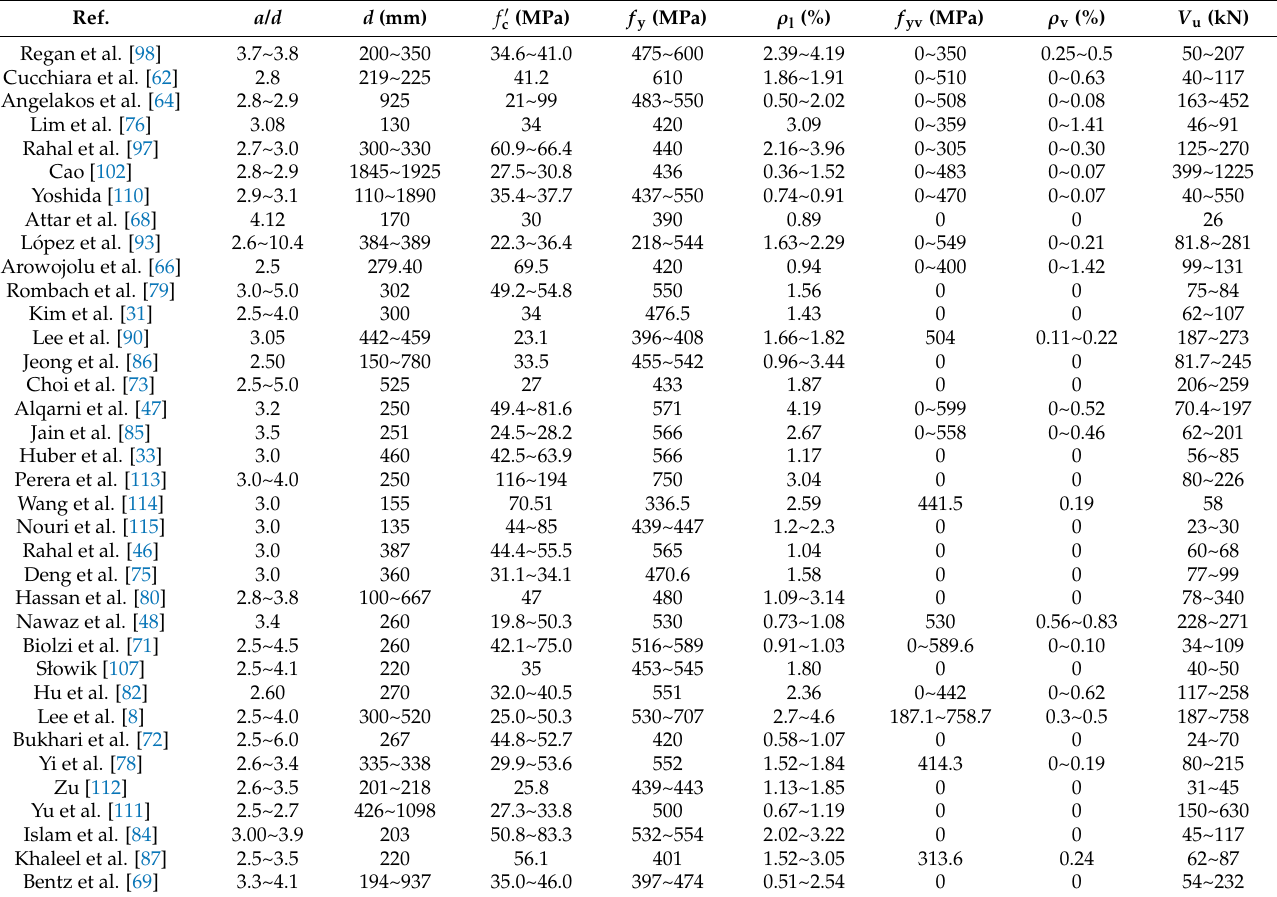
Table A3. Experimental database of RC slender